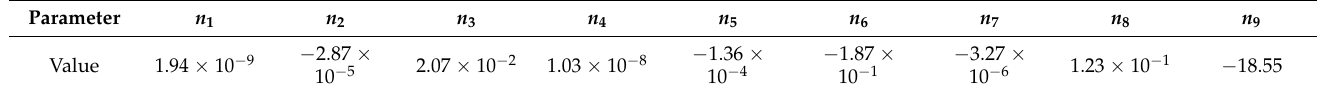
Table 4. Parameters of Equation (18) calculated from the training data